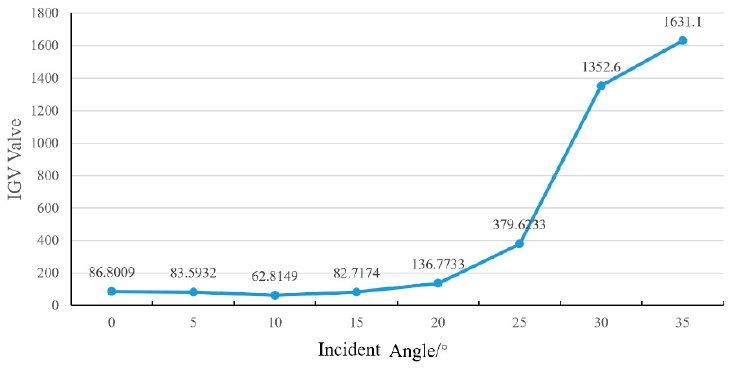
Figure 4. The image gray variance values changing with the incremental incident angle.